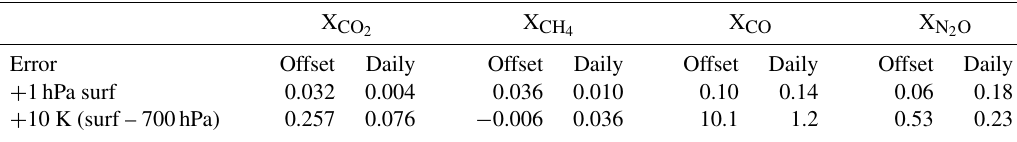
Table 4. Meteorological sensitivity tests on EM27/SUN retrievals.